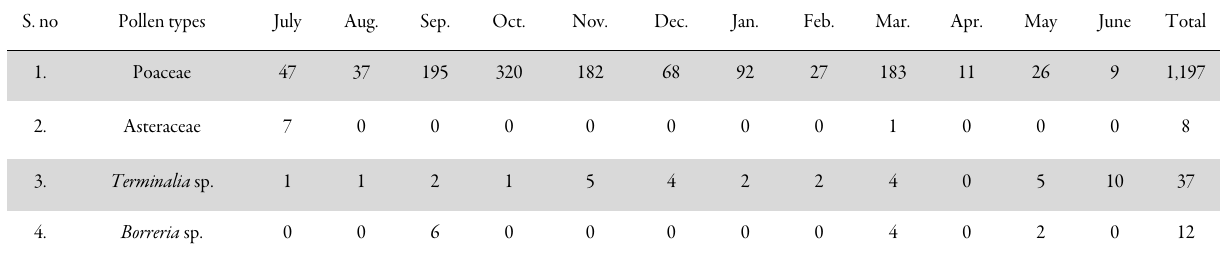
Table 2. Frequency of atmospheric pollen and fern spores recovered from the study location in Sokoto State, Nigeria (July 2015 to June 2016) S.